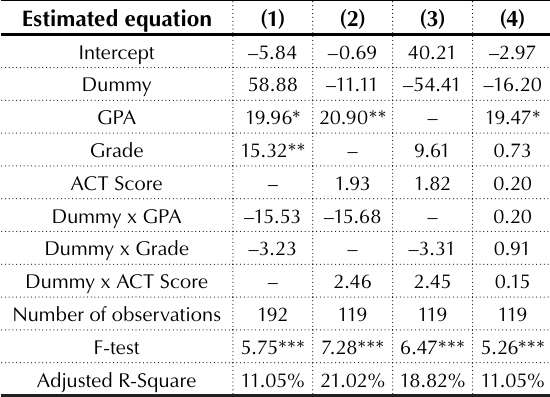
Table 5. Regression results with the final exam scores (FINAL_EXAM) as the dependent